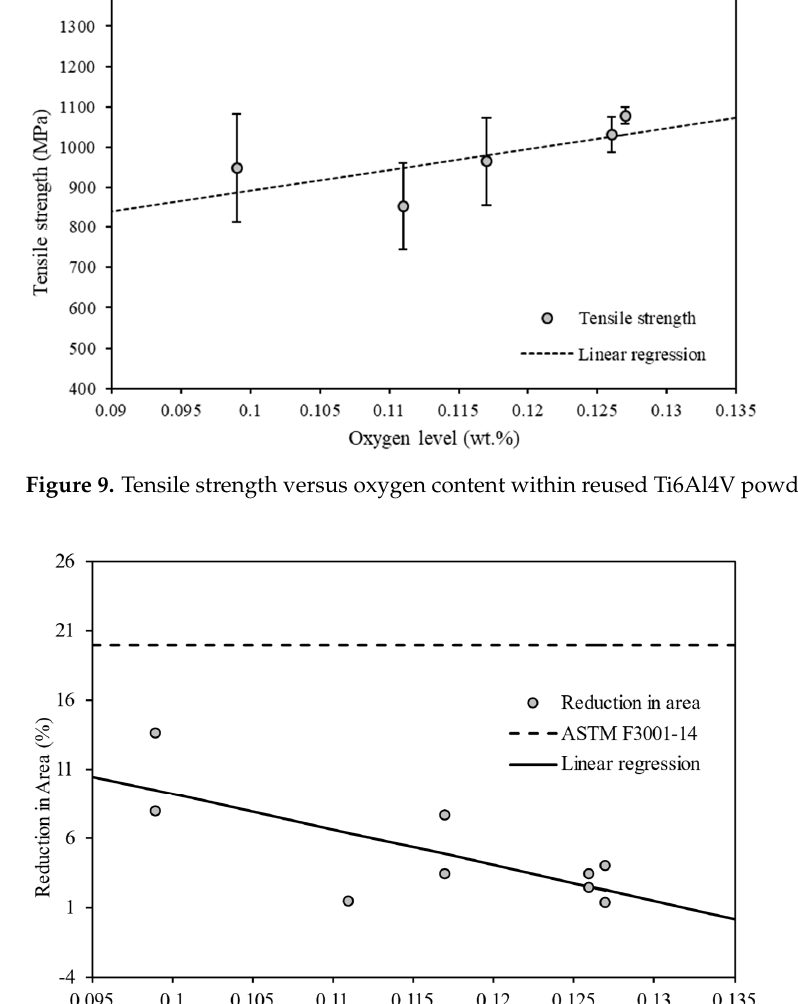
Materials 2022 , 15 , x FOR PEER REVIEW Figure 8. Mean tensile strength measured for build cycles 2, 3, 5, 7, and 9 with standard error bars. The mean tensile strength against oxygen content within the recycled powder is pre- sented in Figure 9 along with the corresponding line of best fit.